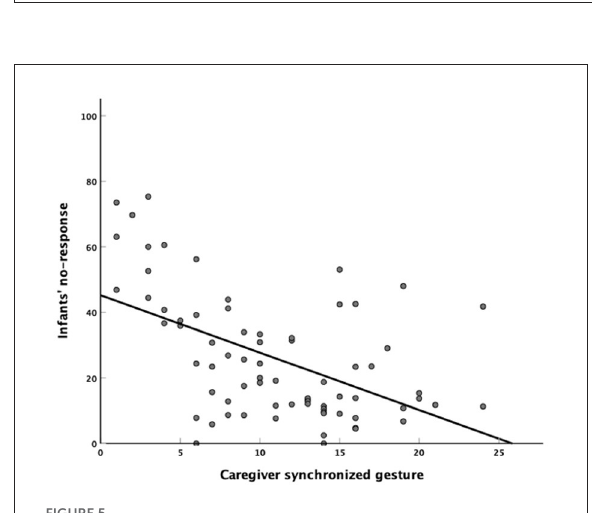
FIGURE5 Scatterplot with a best-fit line depicting the relationship between caregiver’s synchronized gestures and autism spectrum disorder’s no-responses during play